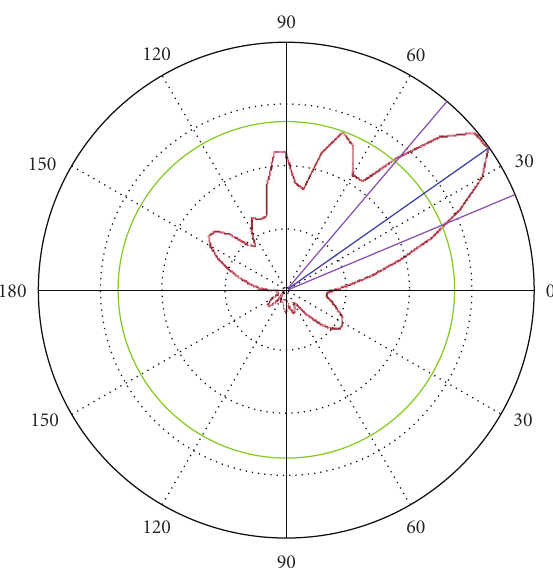
Figure 11: Radiation patterns of electric field (H plane) LWA Type I, at